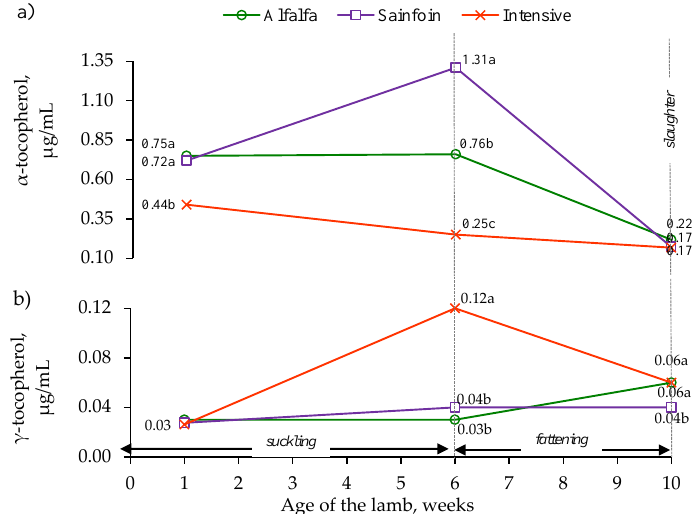
Figure 2. Effect of the maternal feeding on the plasma α-tocopherol (a) and γ-tocopherol (b) Figure 2. E ff ect of the maternal feeding on the plasma α -tocopherol ( a ) and γ -tocopherol concentrations in the lamb. Within an age, the means with different letter differ at P < 0.05. ( b ) concentrations in the lamb. Within an age, the means with di ff erent letter di ff er at p <